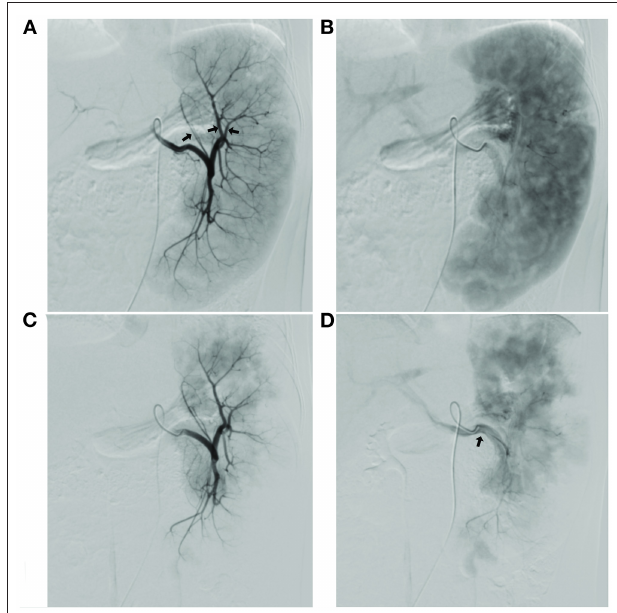
FIGURE 1 | (A) Image of the splenic segment arteries in arterial phase, with the planned preservation of the superior pole splenic segment artery shown by the arrow; (B) Image of the spleen in the equilibrium phase, showing the full projected area of the spleen; (C) Image of splenic segment artery after super-selective partial splenic embolization (SPSE) with preserved superior pole splenic segment artery; image of the spleen in equilibrium after SPSE with the area of residual spleen projection, with estimated embolization extent of up to 90% compared to (B) ; (D) Splenic vein imaging.